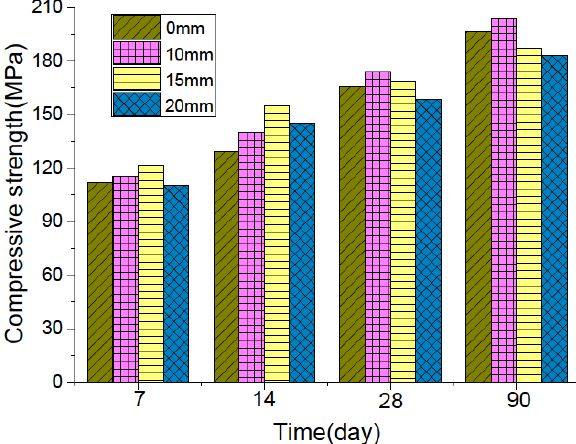
Figure 5: Influence of maximum size of aggregate on compressive strength